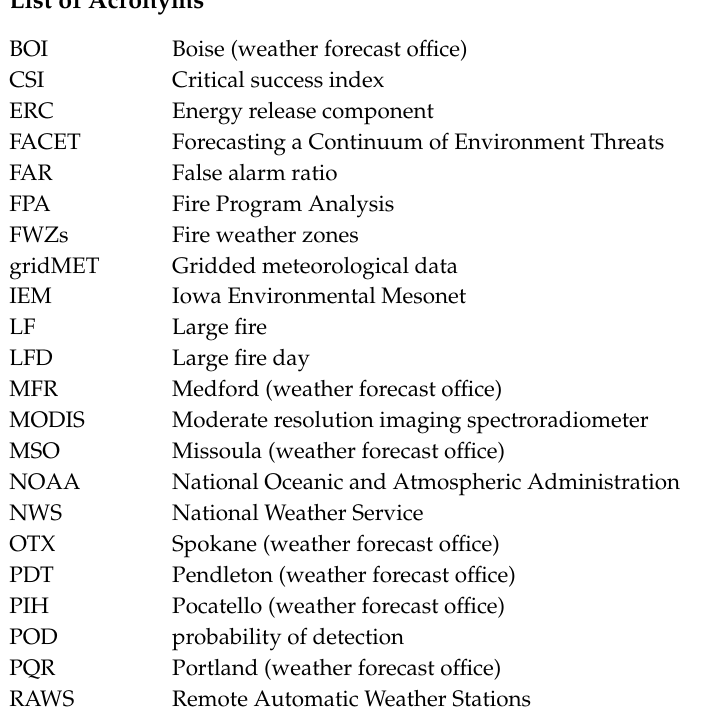
Table S1: Summary statistics for the eight WFOs showing the number of days where an RFW was issued, days when an LF occurred, the mean LF size for the WFO, the number of human- and lightning-caused LF days, and the ratio of LFs occurring on or within one day following an RFW day. Table S2: Complete RFW performance statistics, skill scores, and relative improvement values for large fire days ≥ 80th percentile, ≥ 90th percentile, and ≥ 95th percentile sizes. Table S3: Complete RFW performance statistics, skill scores, and relative improvement values for lightning-caused and human-caused large fire days ≥ 90th percentile sizes. Table S4: Complete RFW performance statistics, skill scores, and relative improvement values for forested and non-forested large fire days ≥ 90th percentile sizes. Table S5: Complete RFW performance statistics, skill scores, and relative improvement values for large fire days ≥ 90th percentile sizes where ERC ≥ 90th percentile values and ERC < 90th percentile